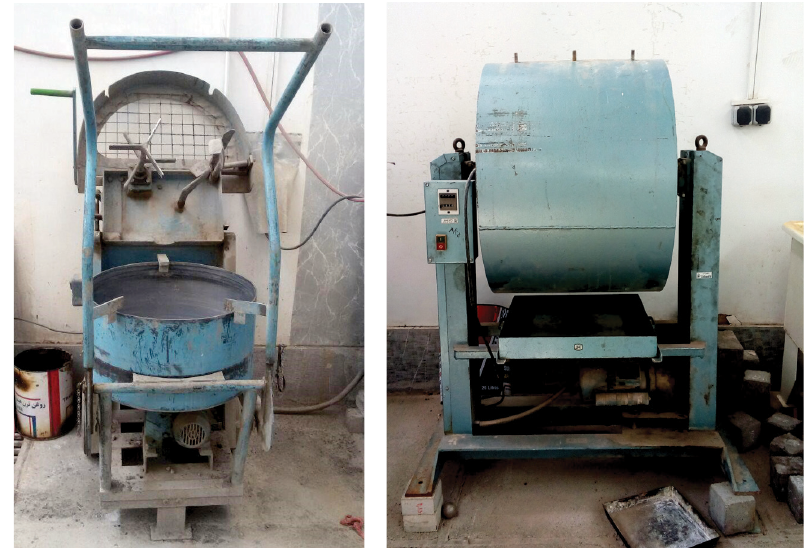
Figure 3. The Los Angeles machine (right) and the mixer (left) used for